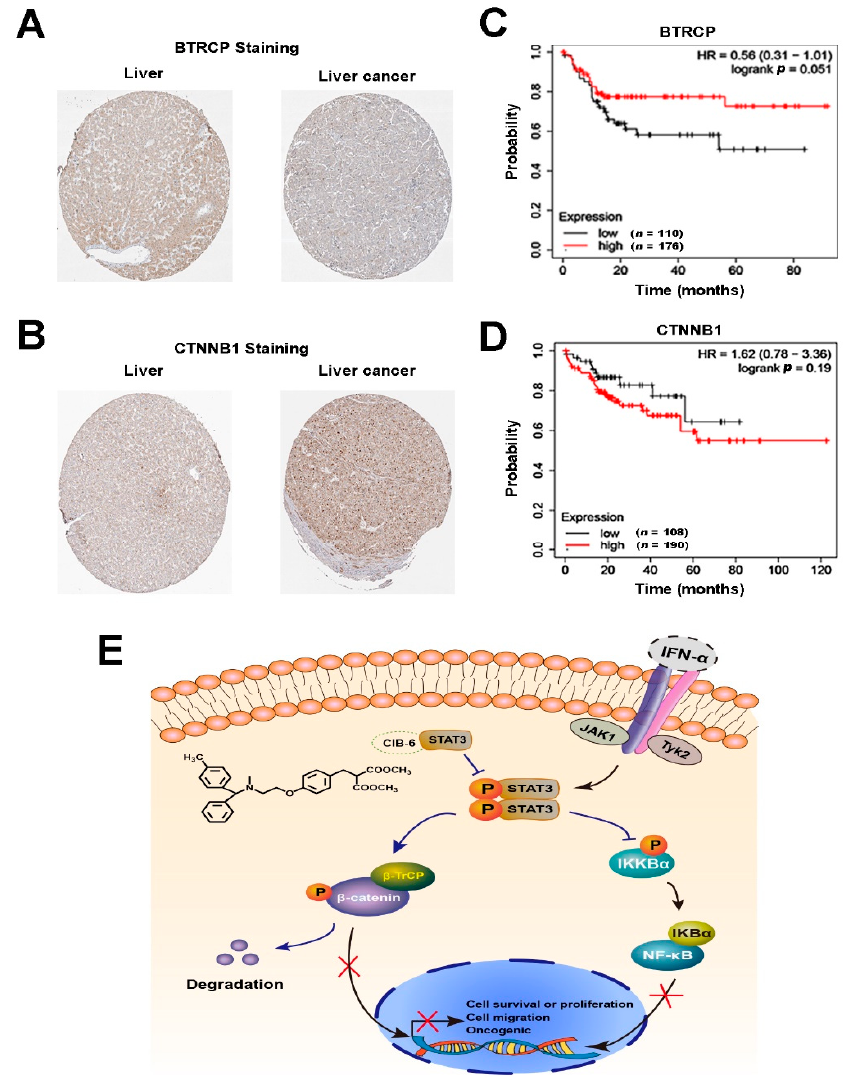
Figure 7. Correlation of β -catenin and β -TrCP expression with human HCC development. ( A , B ) Expression of β -TrCP and β -catenin in normal liver tissue and liver cancer tissue. ( C , D ) Kaplan–Meier survival curve for β -TrCP and β -catenin in hepatitis-associated HCC patients. ( E ) Schematic summary of the mechanism of CIB-6 in the suppression of HCC. CIB-6 inhibits STAT3 activation to upregulate β -TrCP expression, promote β -catenin degradation, and curb NF- κ B activation by restricting IKK phosphorylation, ultimately leading to the suppression of HCC proliferation and metastasis.